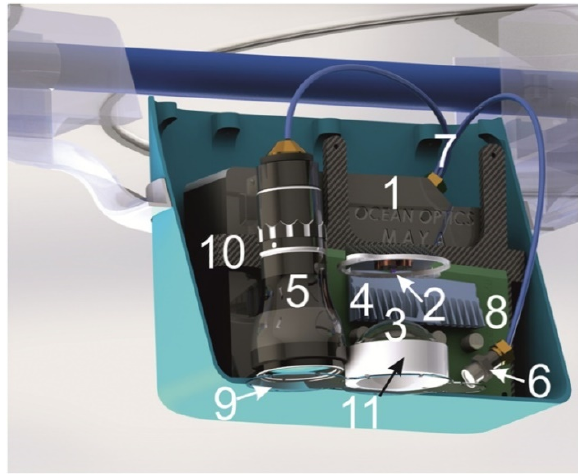
Figure 1. Smallsized laser-induced fluorescence (LIF) spectrometer. 1—Maya 2000Pro spectrometer,